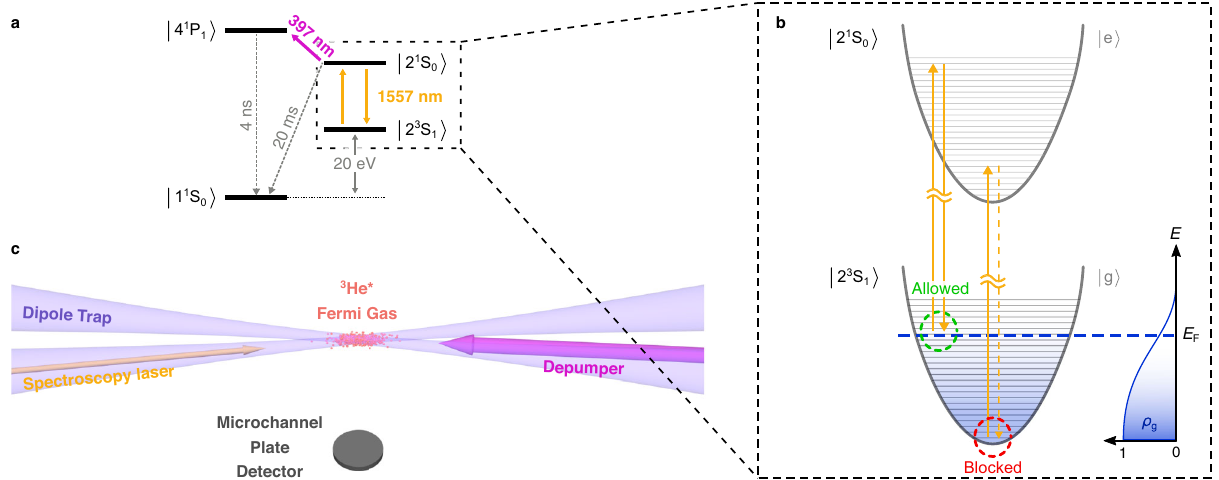
Fig. 2 | Description of the experimental con fi guration and the Pauli blocking mechanism. a Energy scheme showing the relevant electronic levels of helium. A depumperbetweenthe2 1 S 0 andthe4 1 P 1 statescanarti fi ciallyreducethelifetimeof the 2 1 S 0 state. b Vibrational states induced by the optical dipole potential and depiction of the Pauli blocking mechanism depending on the state occupation: stimulatedemissionisinhibitedforlow-energystateswhereasitisallowedforhigh-